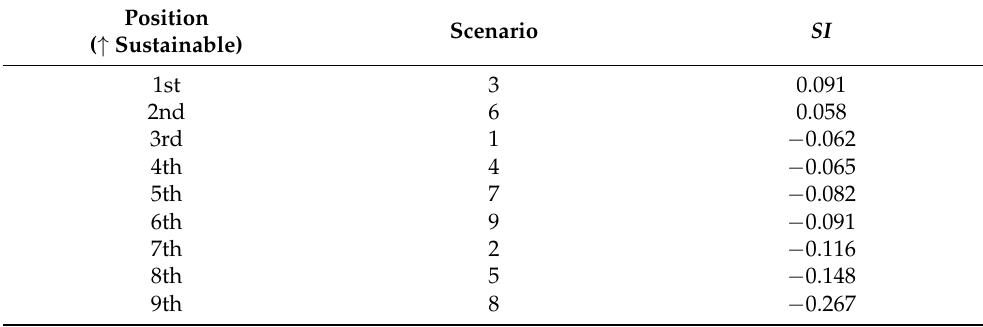
Table 11. Sustainability Index ( SI